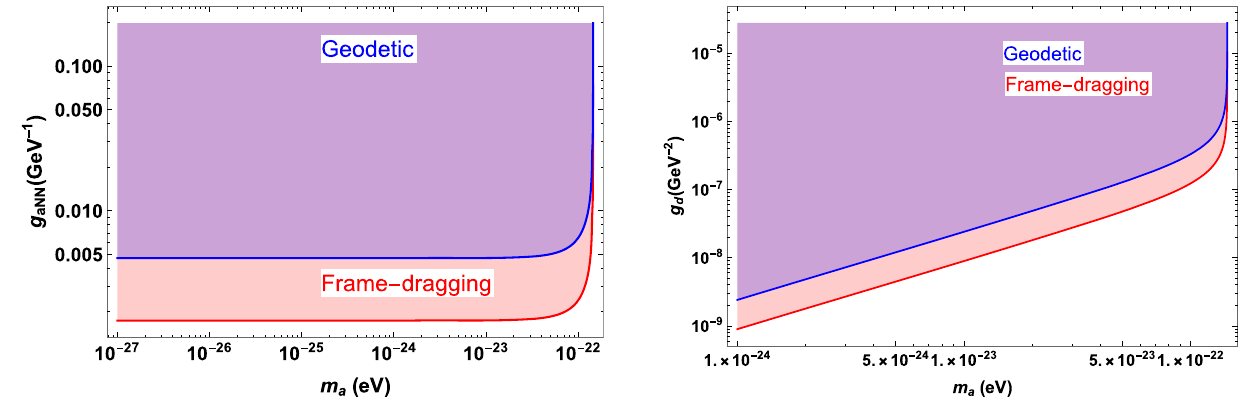
is suppressed by ∼ 2 π of linear growth of the precession angle. The effect adds coherently for m a (cid:3) 2 π